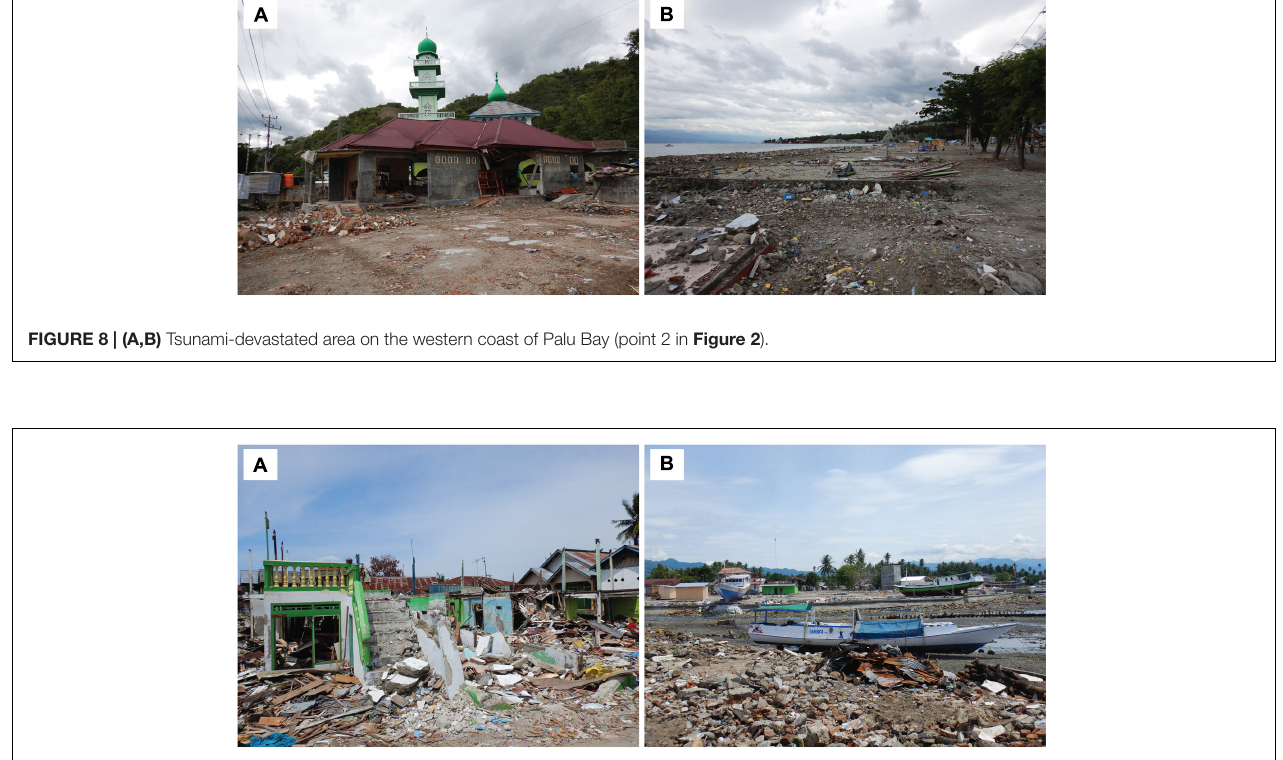
FIGURE 9 | (A,B) Severely-damaged port area on the eastern coast of Palu Bay (point 7 in Figure 2 ).